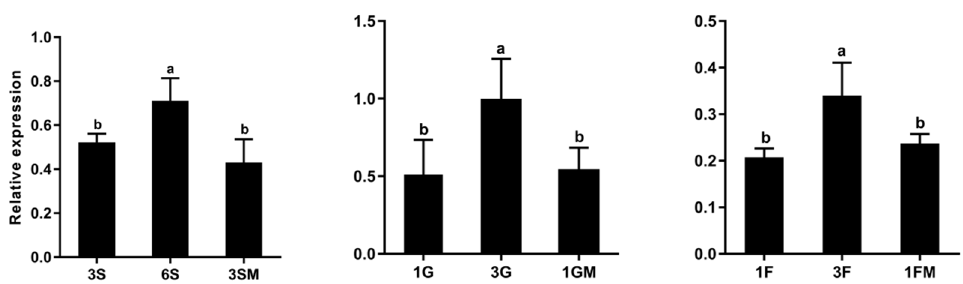
Figure 2. qRT-PCR detected the expression of CmTST1 in melon roots under different sugar conditions. 3S, 3% Suc; 6S, 6% Suc; 3SM, 3% Suc + 3% Man; 1G, 1% Glu; 3G, 3% Glu; 1GM, 1% Glu + 2% Man; 1F, 1% Fru; 1FM, 1% Fru + 2% Man. Mannitol was added as the control to exclude the influence of osmotic pressure. Lowercased letters above the bar indicate that significant differences between different sugar treatments were assessed by one-sided paired t-tests ( p < 0.05).